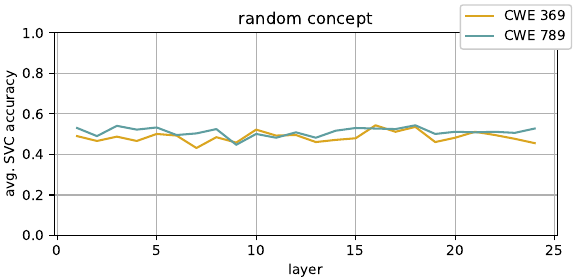
Figure 6. Average accuracies obtained over 10 runs by the linear SVCs trained on random